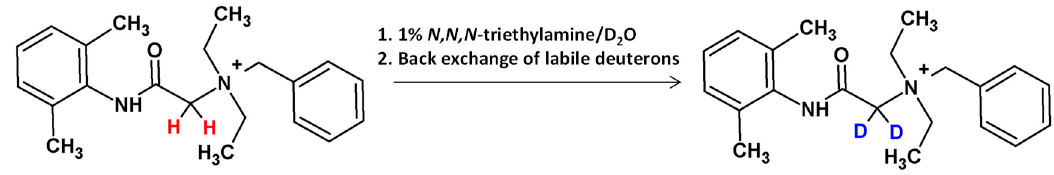
Figure 14. Preparation of deuterated Bitrex standard for quantitative analysis by mass spectrometry.